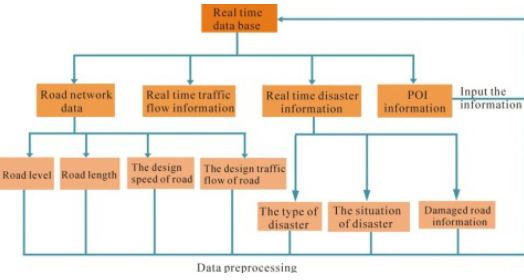
Figure 5. The conceptual graphs of Real-time data base